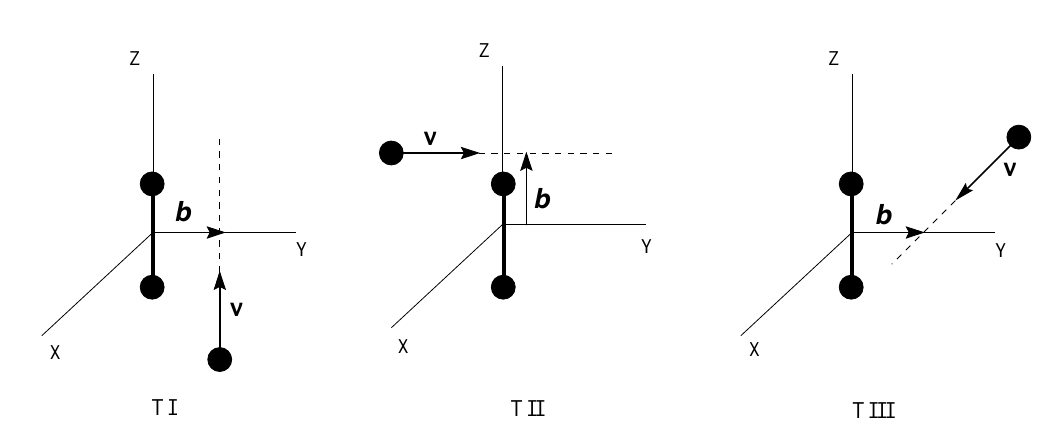
Figure 1: Geometry of the trajectories TI, TII and TIII used to evaluate the OACS in eq. (21). 3. Trajectory III: b ⊥ ρ , v ⊥ ρ